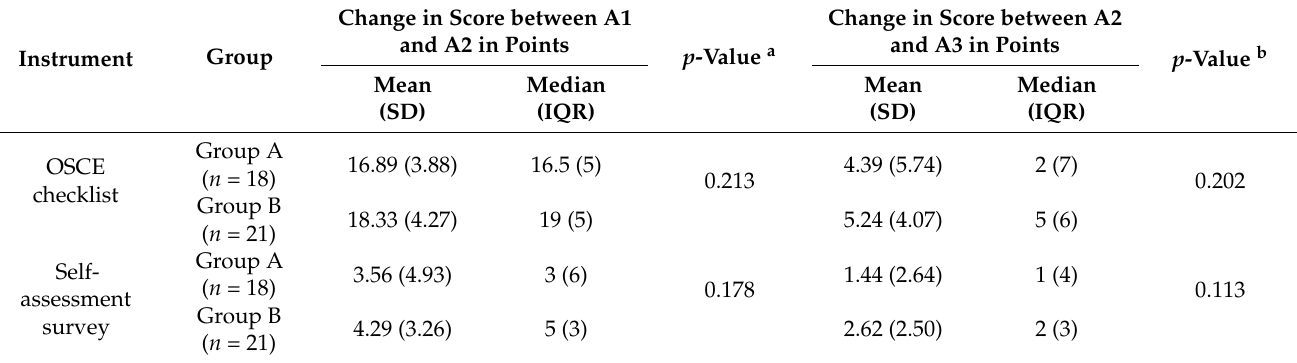
Figure 2. OSCE score per group. Black cross mark ( × ) = mean; horizontal line = median; black diamond ( ♦ ) = outlier; diamond ( (cid:7) ) = outlier; white diamond ( ♦ ) = extreme value; OSCE = objective structured clinical white diamond (  ) = extreme value; OSCE = objective structured clinical examination; A1 = assessment 1; A2 = assessment examination; A1 = assessment 1; A2 = assessment 2; A3 = assessment 3. 2; A3 = assessment 3. Table 2. Changes in OSCE score and self-assessment